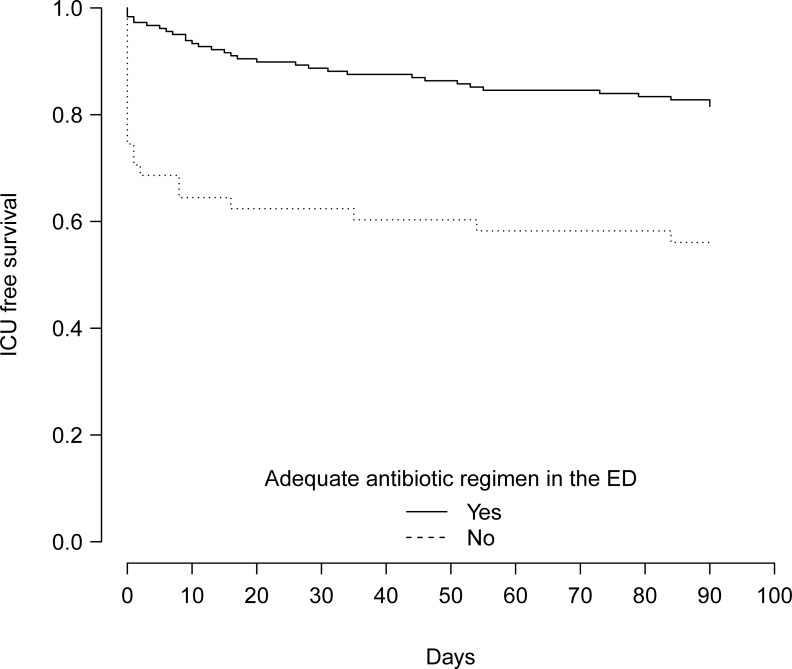
Kaplan-Meier curves of the ICU free survival during 90 days from ED presentation depending on the appropriateness of the antibiotic regimen initiated in the ED.